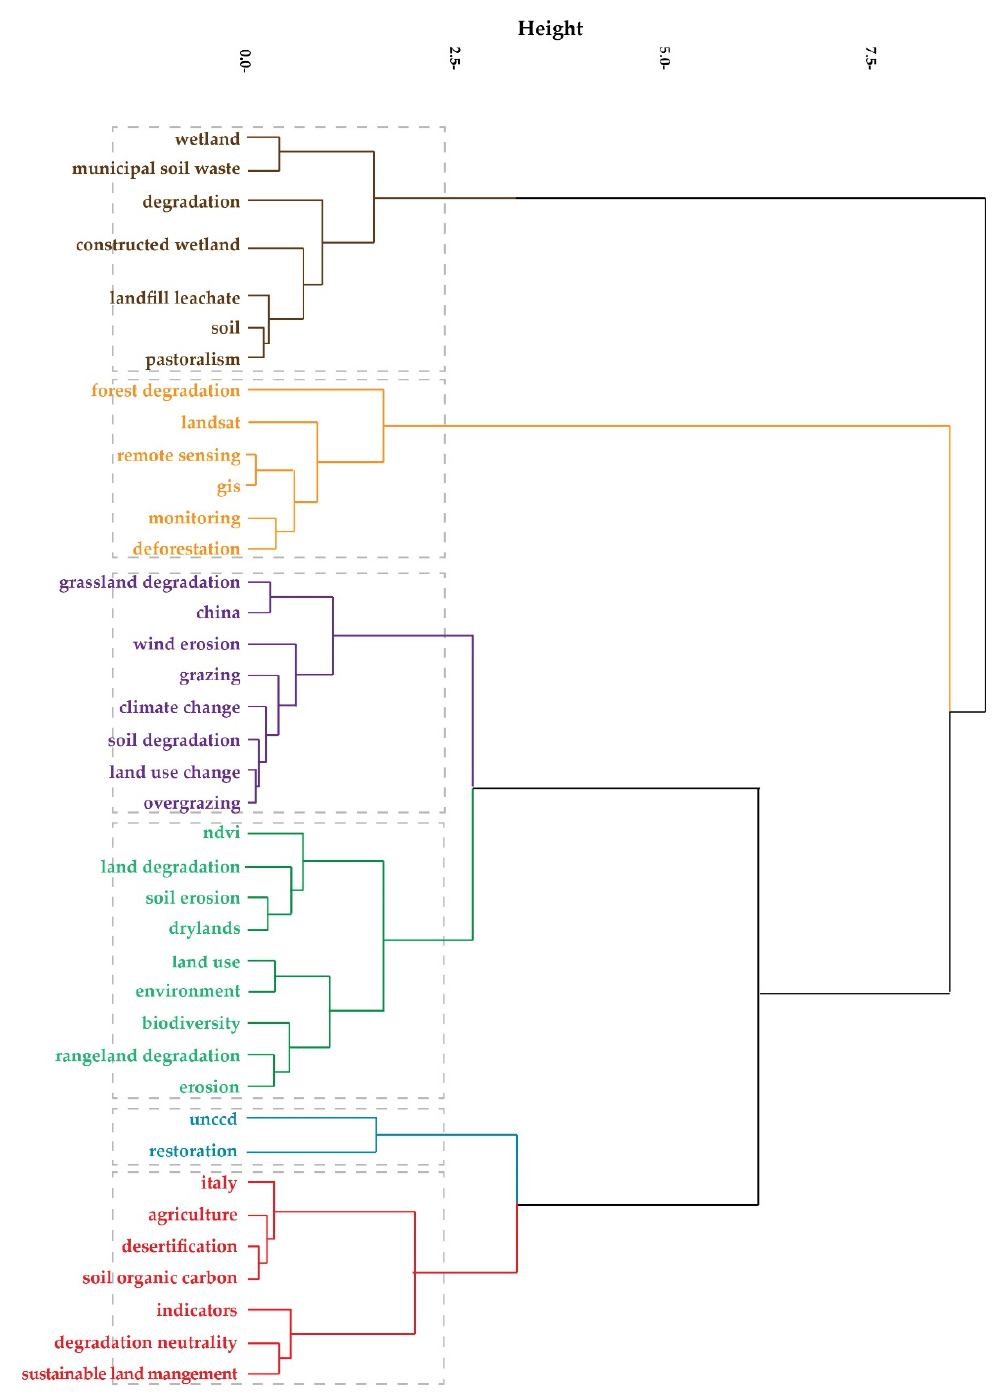
Figure 12. Tree dendrogram of hierarchical cluster analysis of key words in the field of land degradation.